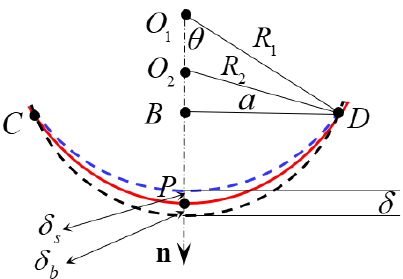
Figure 1. Geometrical relationship between socket and ball after contact. The total normal deformation δ is given by,